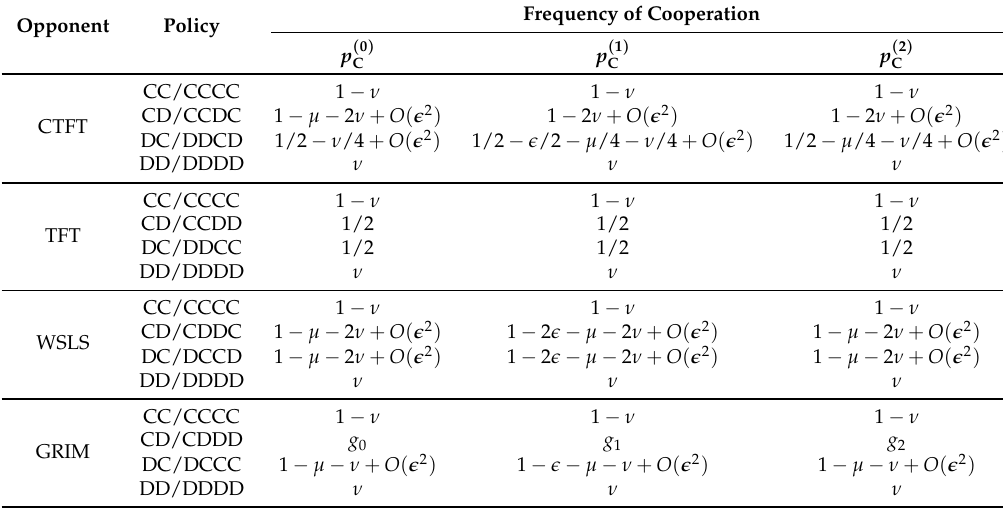
Table 3. Frequencies of cooperation in infinitely repeated games. Here, (cid:101) ≡ ( (cid:101) , µ , ν ) T